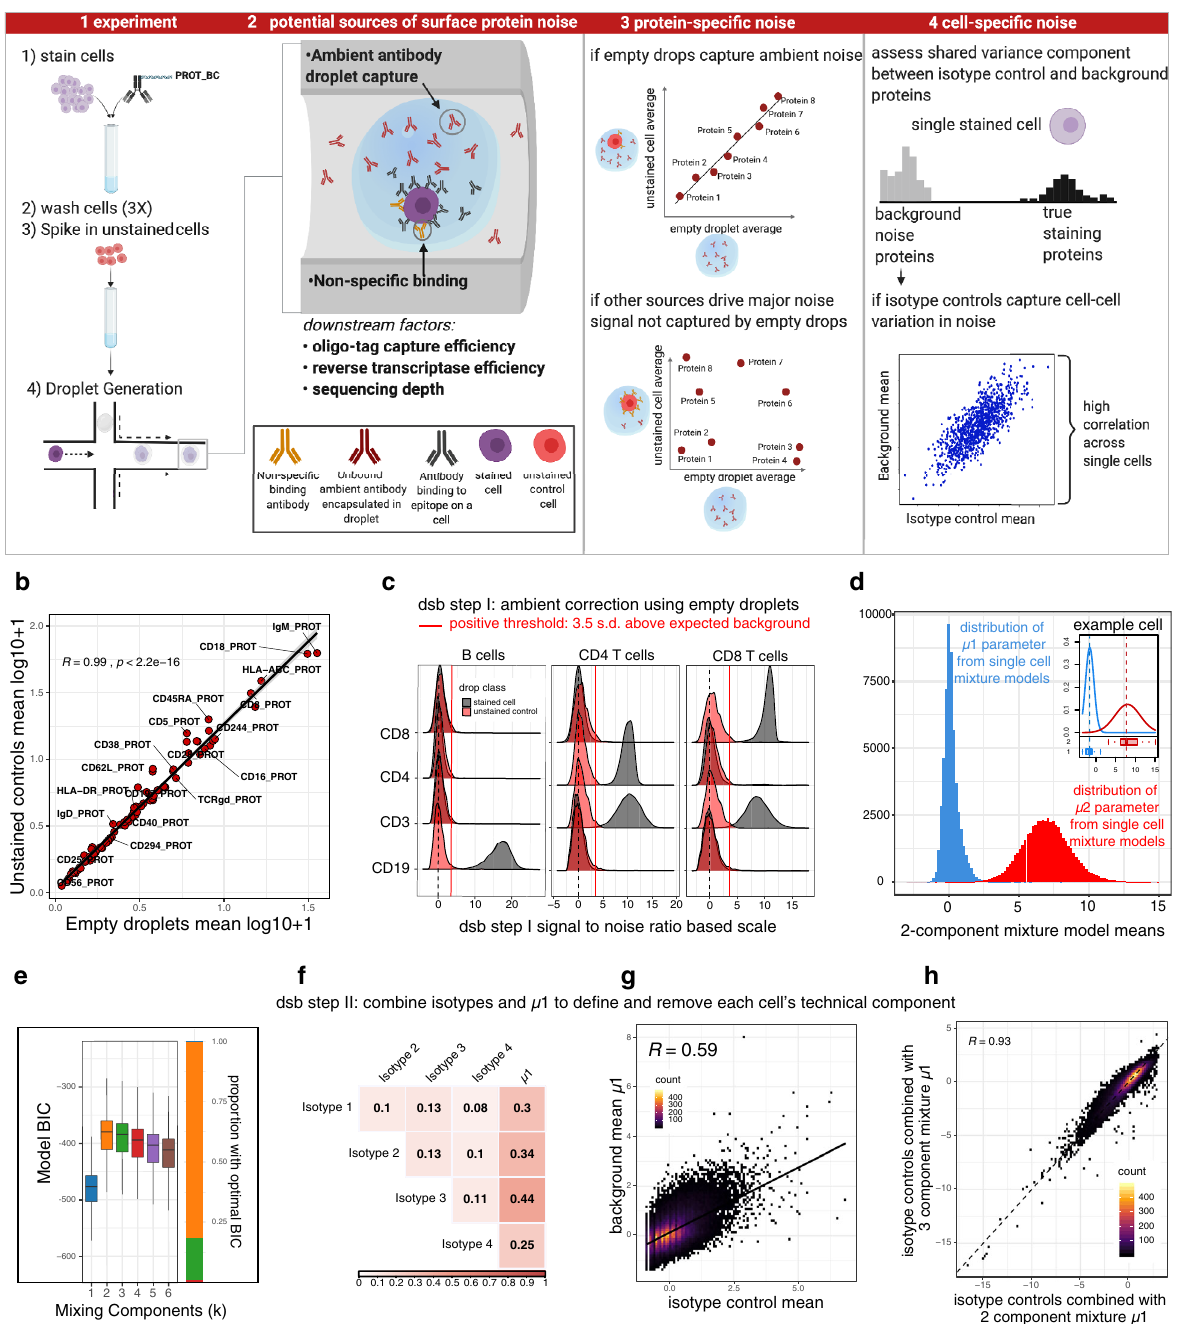
dividing by the standard deviation of that same protein across empty droplets (see the “ Methods ” section). The resulting transformed protein expression values for each cell re fl ect the number of standard deviations above the expected ambient cap- ture noise, thus centering the negative cell population for each protein around zero to help improve interpretability of the resulting protein expression values (Fig. 1c). Shared variance between isotype controls and background protein counts in single cells provide cell-intrinsic normal- ization factors . In addition to ambient noise correlated across single cells as captured by average readouts from empty droplets,